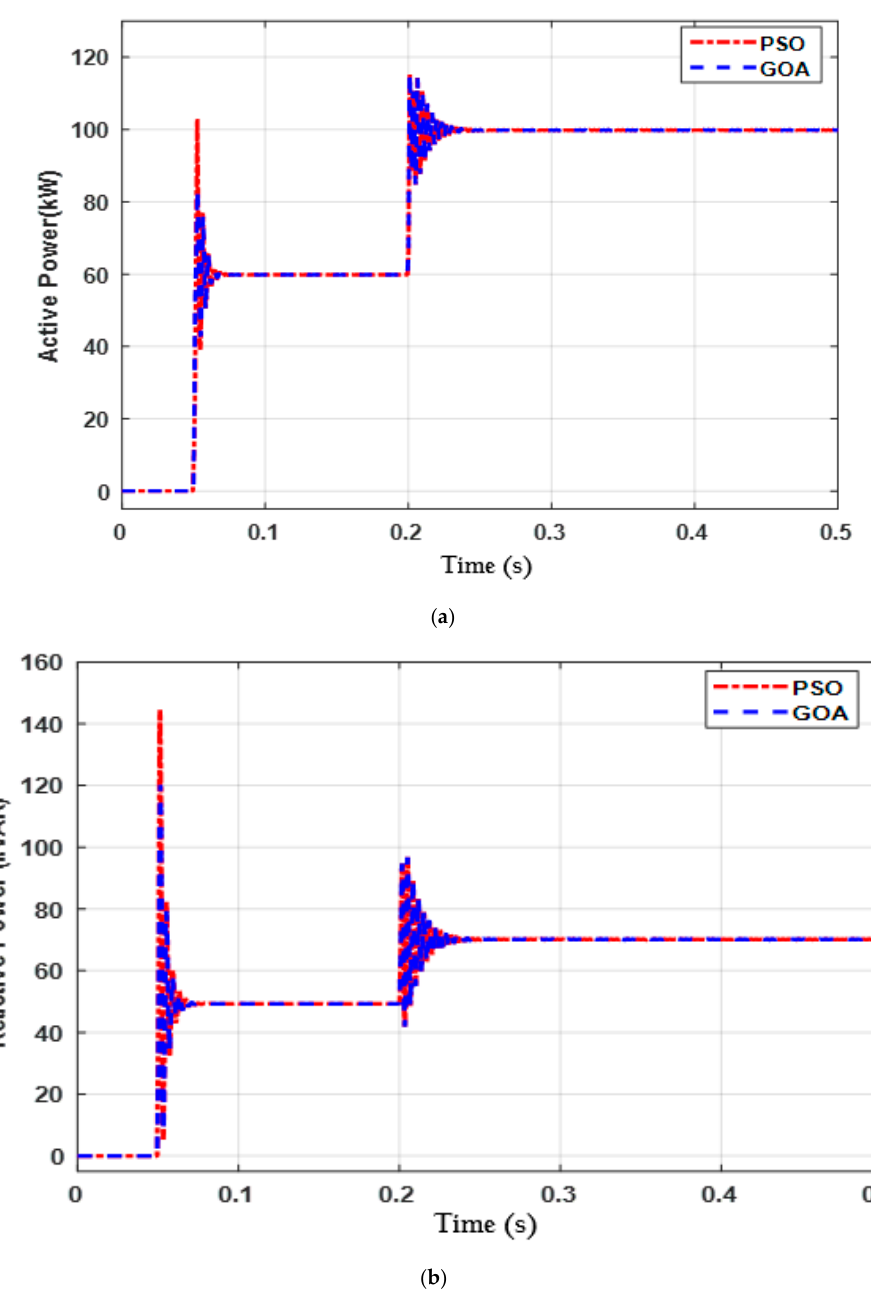
Figure 10 PSO versus GOA for ( a ) active power and ( b ) reactive power regulation. Figure 10. PSO versus GOA for ( a ) active power and ( b ) reactive power